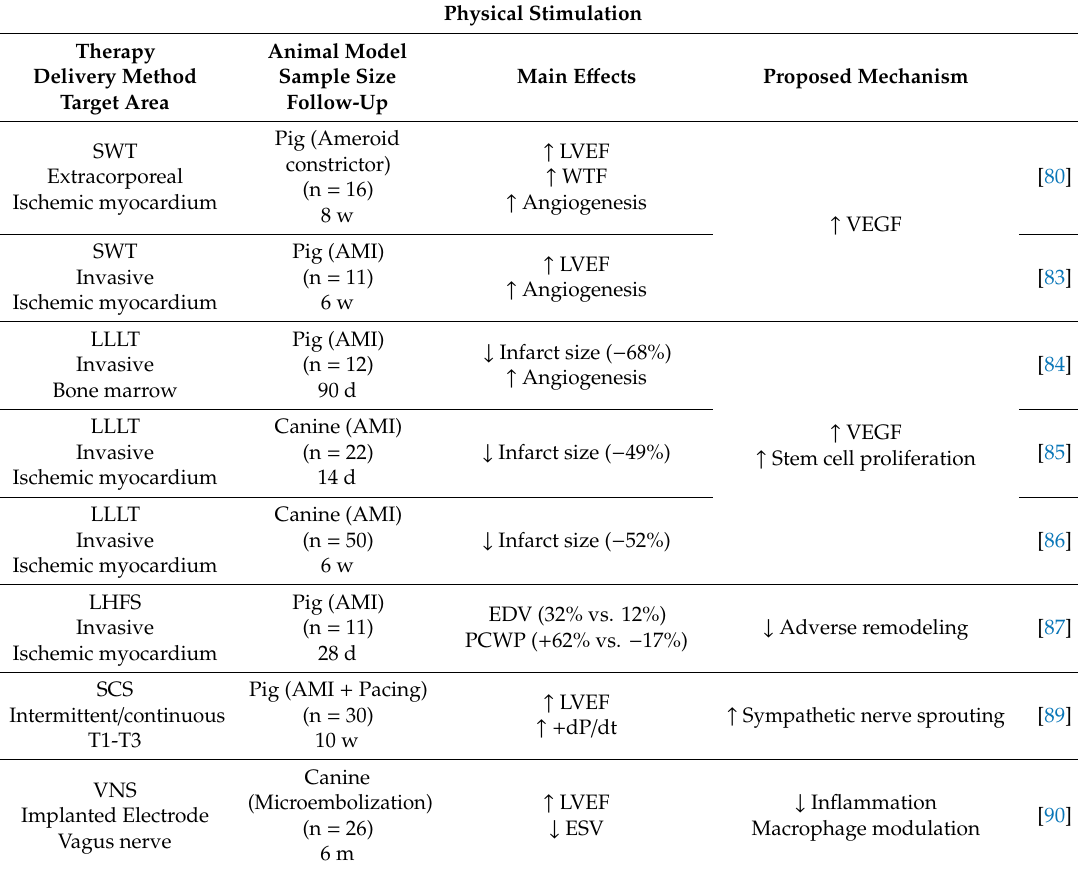
Table 4. Overview of large animal models of physical stimulation for cell-free cardiac